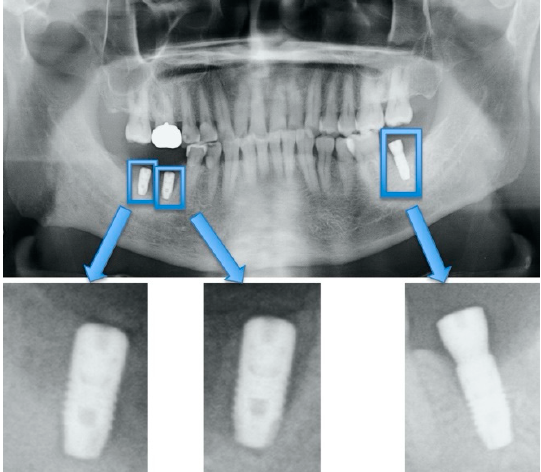
Figure 1. Cropping of dental implant imagery to include single fixtures. Biomolecules 2020 , 10 , x FOR PEER REVIEW